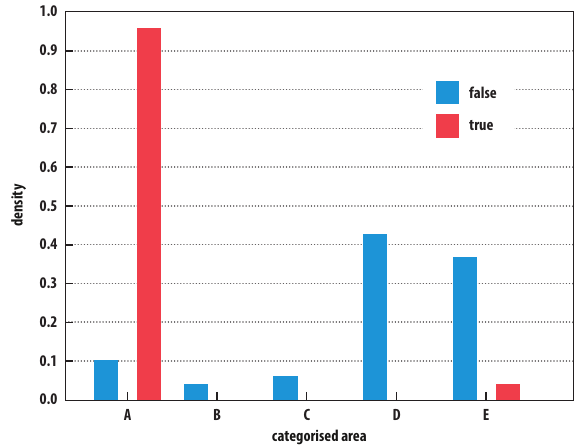
Figure 7. The impact of the feature categorised area on the clas- sification of living-kitchen rooms (true). A room in category A is a living-kitchen room with a high probability.